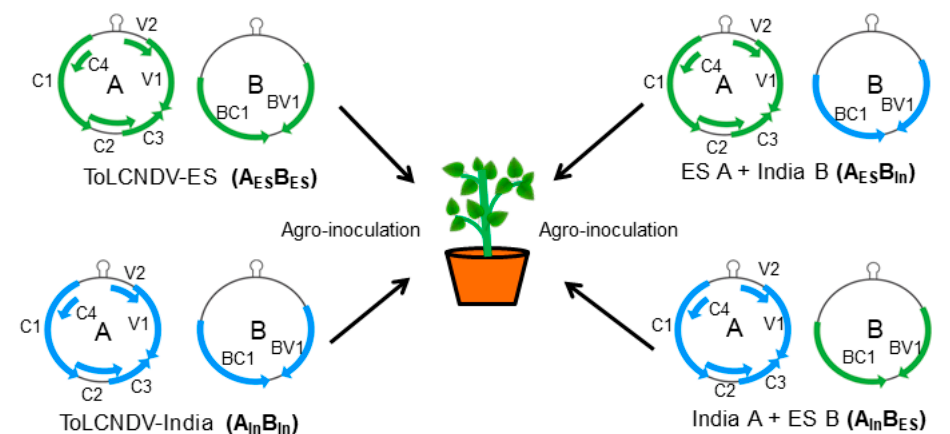
Figure 3. Experiment scheme for the swapped DNA components between two ToLCNDV clones. Component DNA A and B of each ToLCNDV were swapped and combined with other ToLCNDV components to inoculate the cucumber.